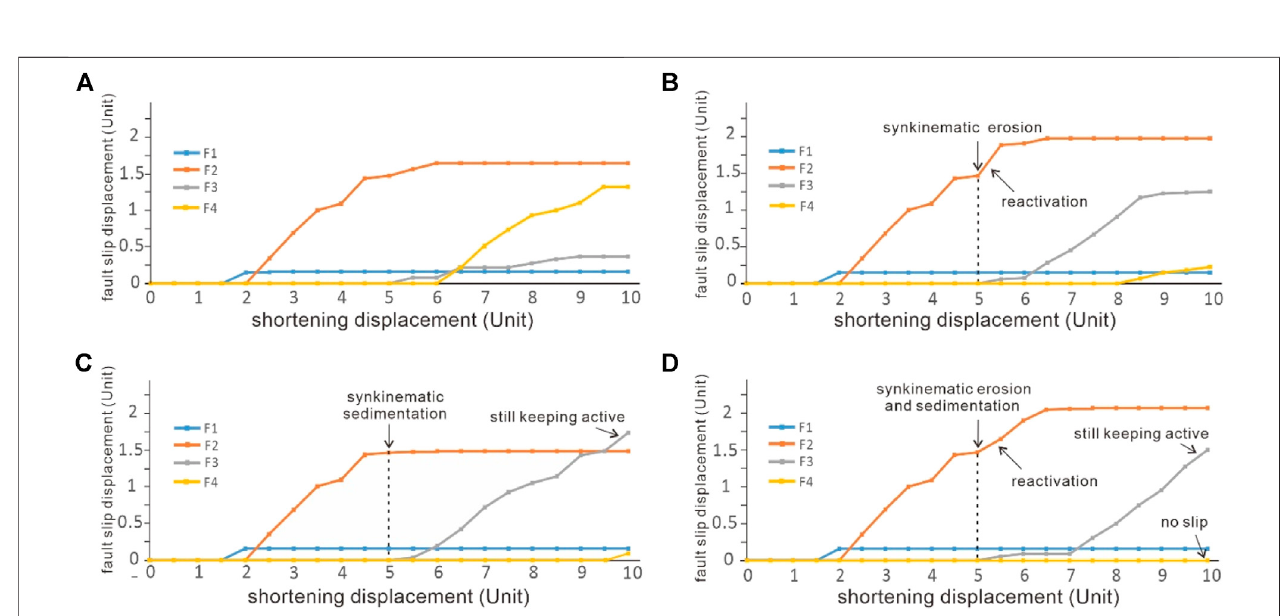
FIGURE 7 | Statistical Graphs of fault slip displacement in Model 1 (A) , Model 2 (B) , Model 3 (C) , and Model 4 (D) .